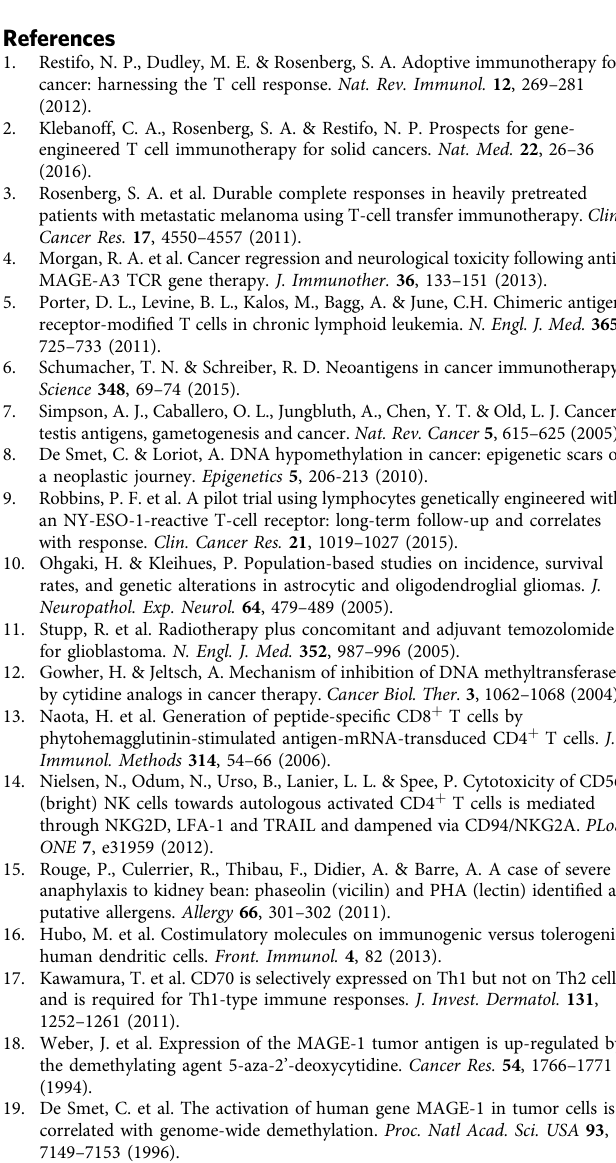
Immunoblotting . The total protein concentration was measured using the Pierce BCA Protein Assay Kit (Thermo Scienti fi c). Aliquots were lysed in Laemmli buffer, boiled for 5min and separated on 12% NuPAGE Bis-Tris gels in MOPS buffer (Invitrogen). Proteins were transferred to a nitrocellulose membrane (Hybond ECL, Amersham), blocked with 5% non-fat dry milk and 5% FCS in TBS, incu- bated with the primary antibody (57B) overnight at 4°C and then with HRP- conjugated rabbit anti-mouse immunoglobulins (1:1000, Dako; Cat.no. P0260) for 1h at room temperature. Reactive bands were visualized by Enhanced Chemilu- minescence (ECL) detection